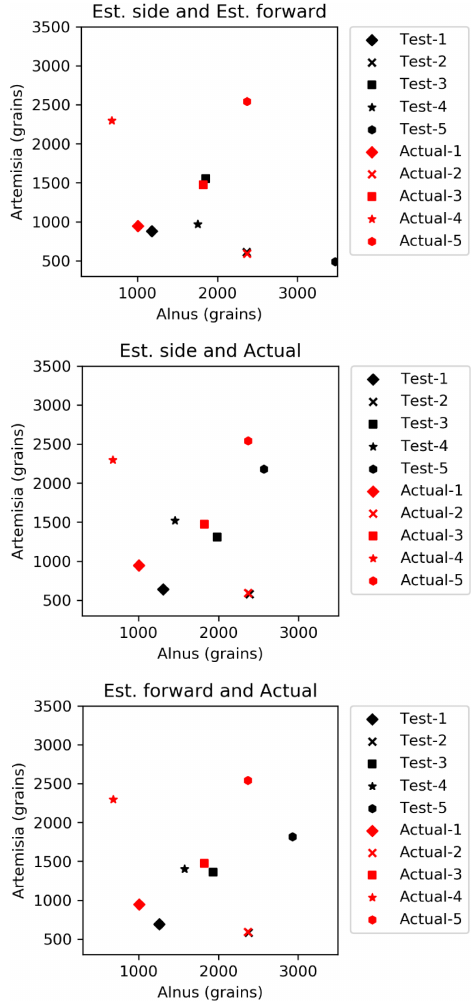
Figure 6. Results of automatic counting of Alnus and Artemisia . Red and black dots represent actual and estimated numbers of pollen grains, respectively. The pairs of red and black dots with the same shape are in the same test